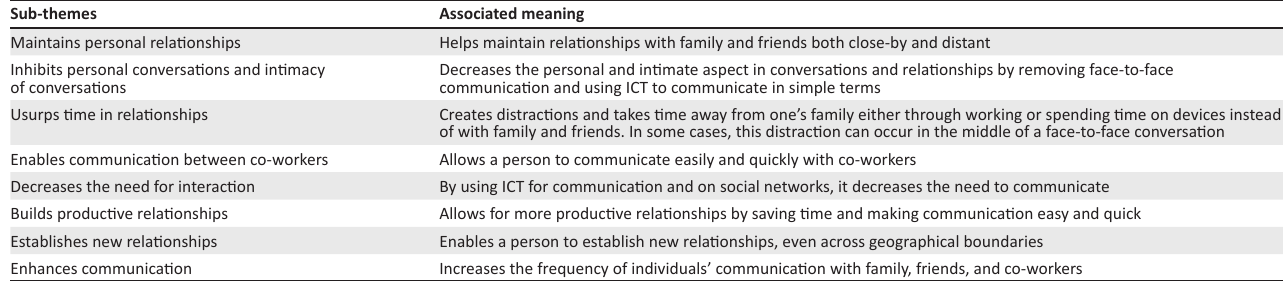
TABLE 5: Theme 5: The role of ICT usage on relationships.